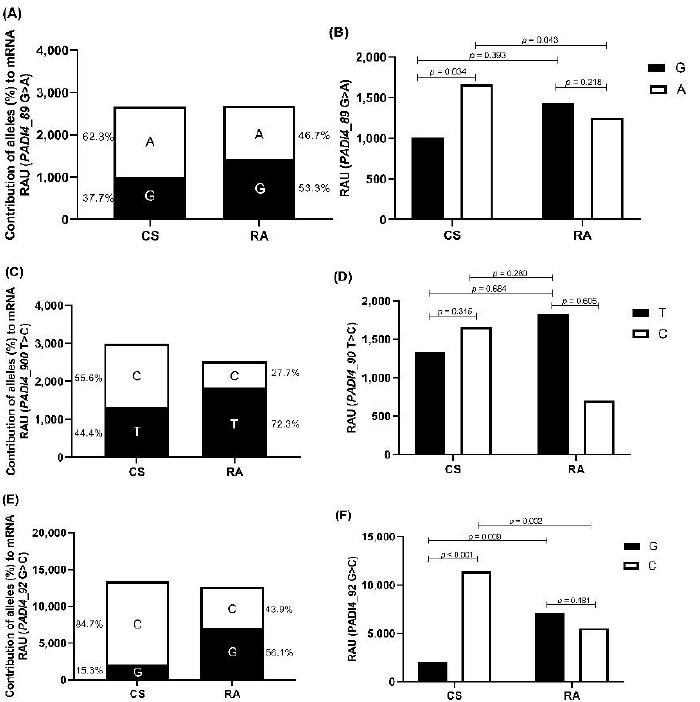
Figure 1. Relative contribution of the PADI4 89G>A, 90T>C, and 92G>C polymorphisms to PADI4 mRNA expression. ( A ) Graphical representation of the results obtained by the ImageJ software of the allelic restriction fragments ratio indicating the relative contribution (%) of G and A alleles of